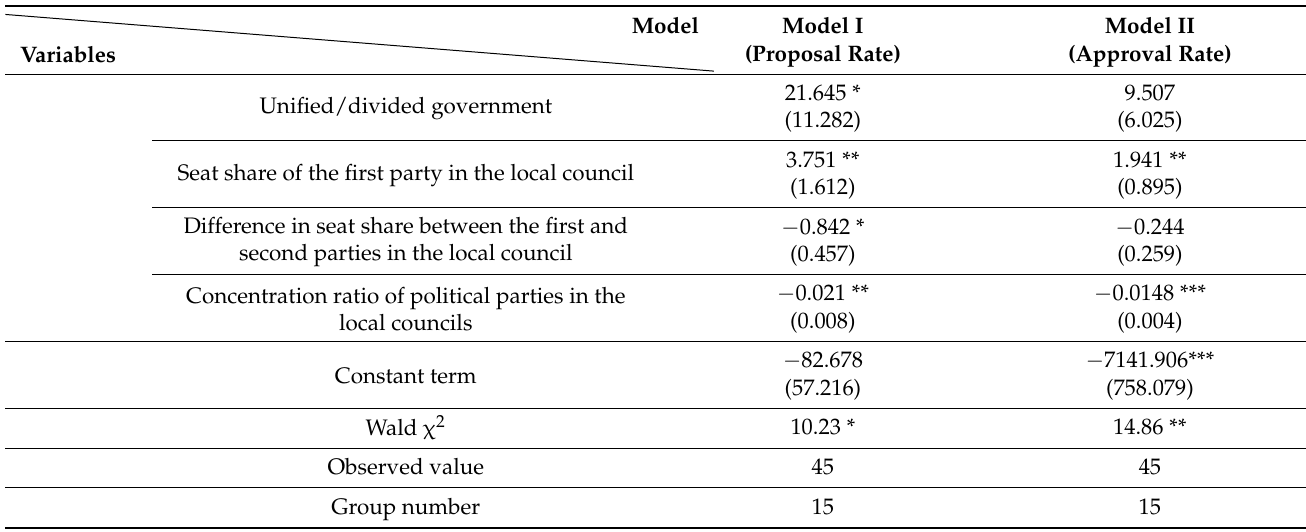
Table 4. Analysis results 1 , 2